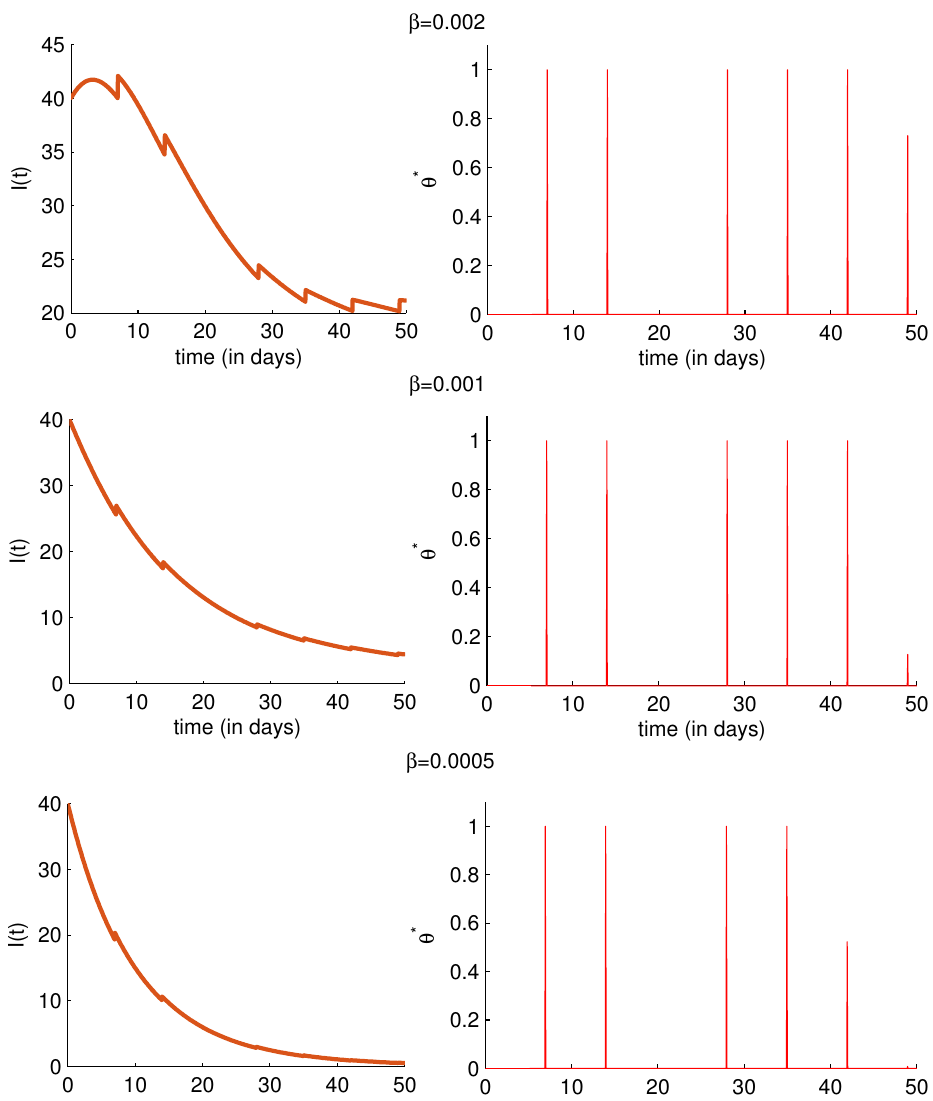
Figure 5. Infection and impulse optimal controls for different values of β . The other parameters are the same as in Figure